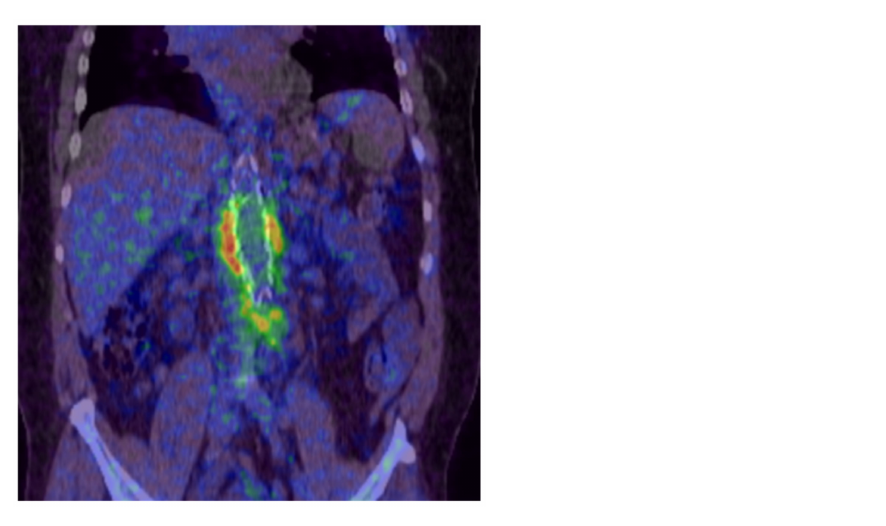
Figure 1. PET-CT scan showing periprosthetic infection of an aortobifemoral bypass (Department of Nuclear Medicine, University Medical Center Regensburg).